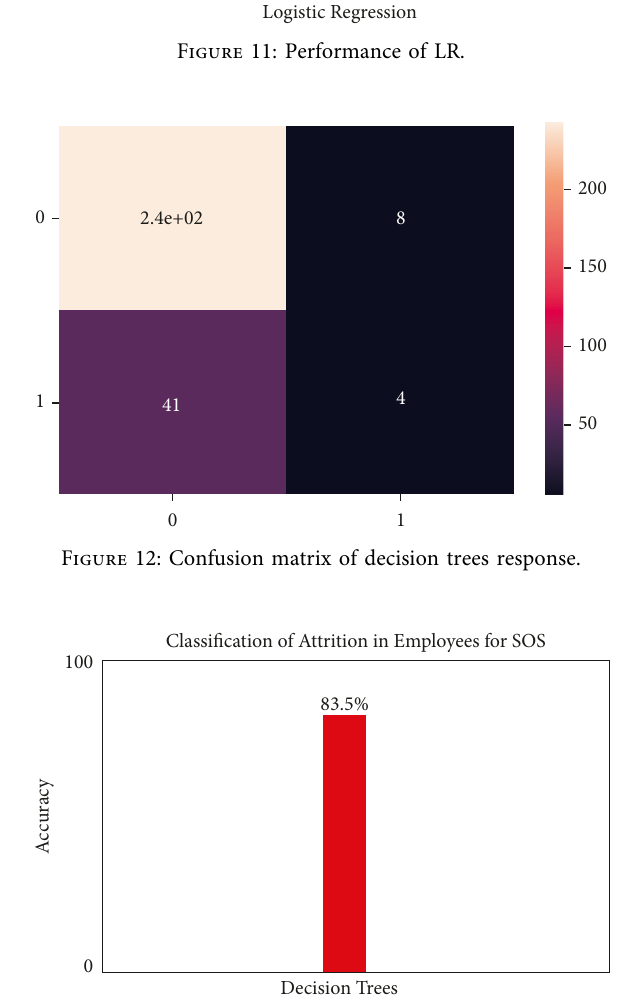
Figure 13: Performance of LR.